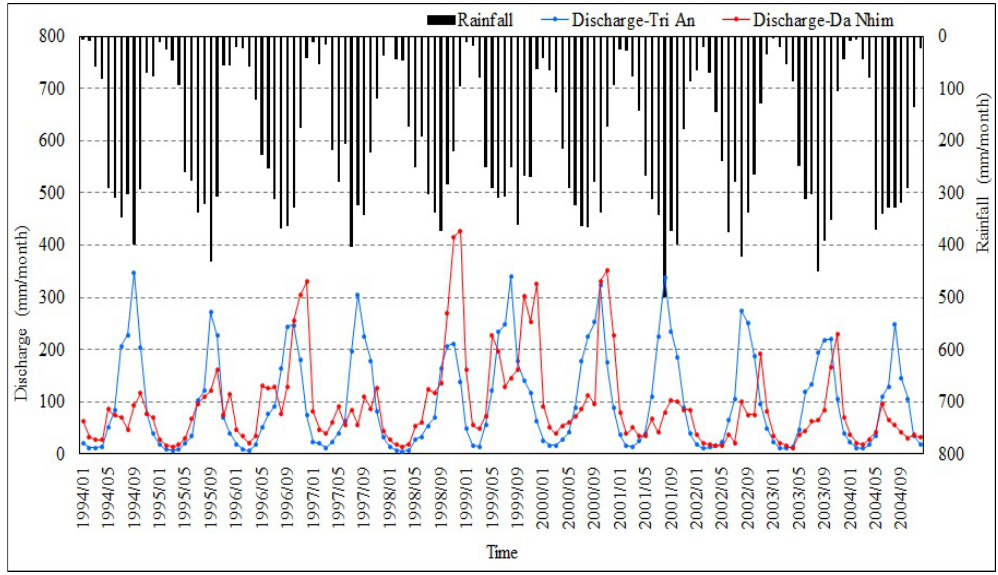
Figure 8. Annual hydrographs at Tri An and Da Nhim.